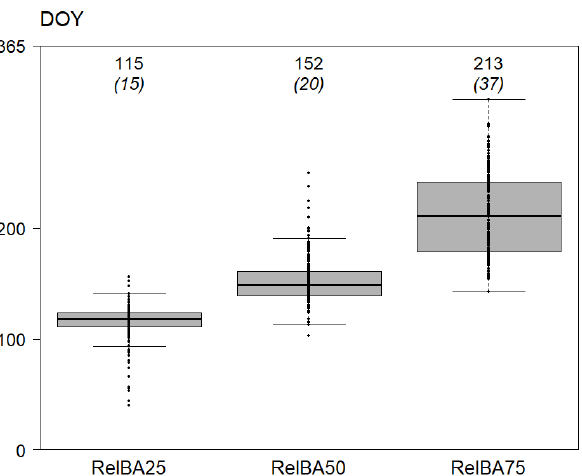
Figure 5. The distribution of the three different dependent variables used in this study: the days of the year (DOY) when 25%, 50% and 75% of the total annual basal area growth were reached. Mean value and standard deviation (italic and in brackets) are given.